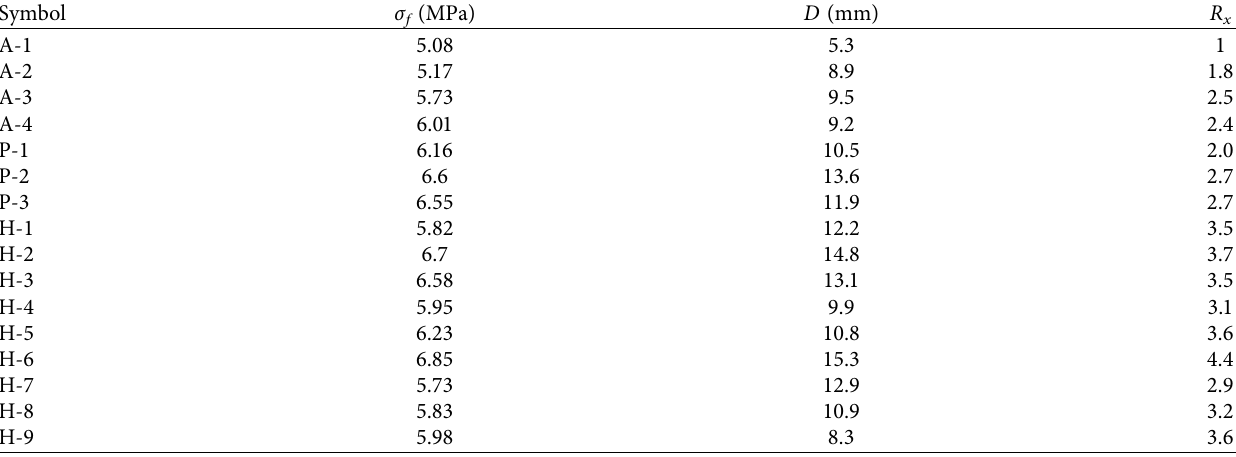
Table 5: Calculation results of the ratio of toughness.